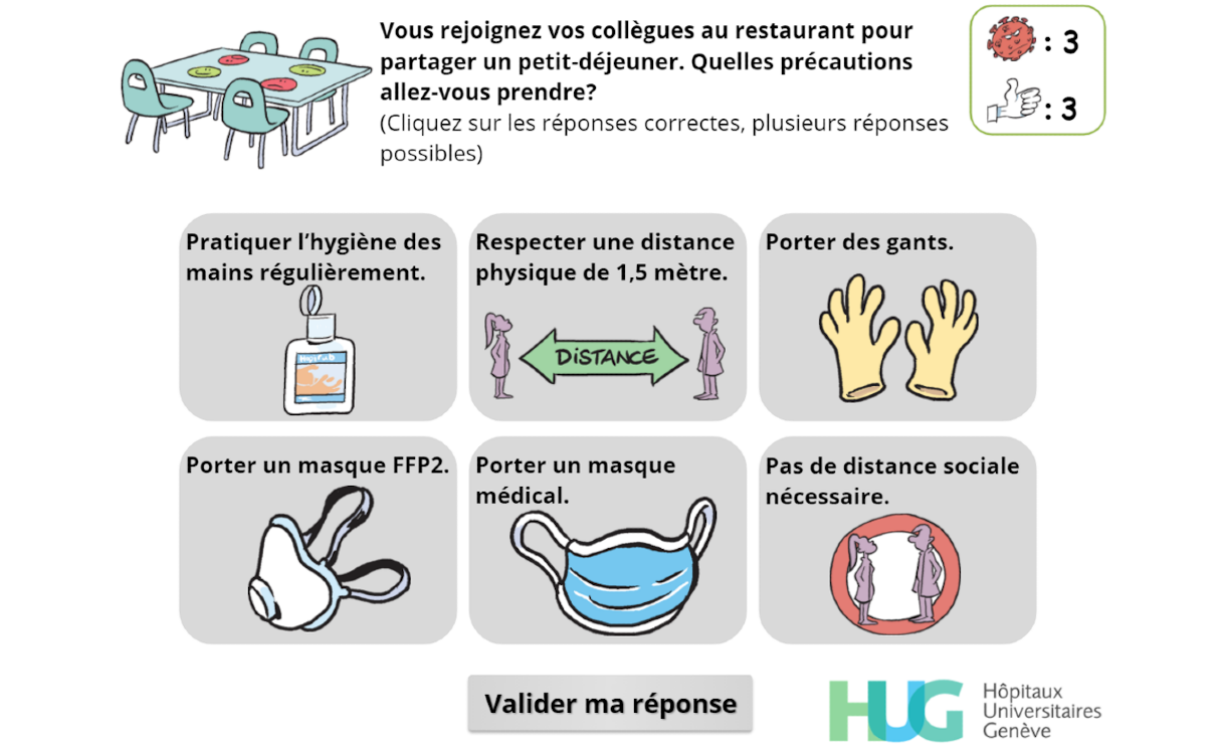
Figure 3. The player has to identify the precautions they should take when joining their colleagues for